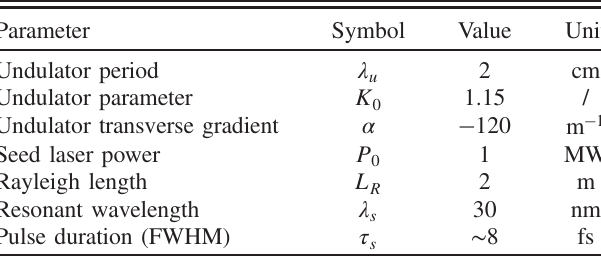
TABLE III. The parameters of TGU and seed laser for FEL simulation.